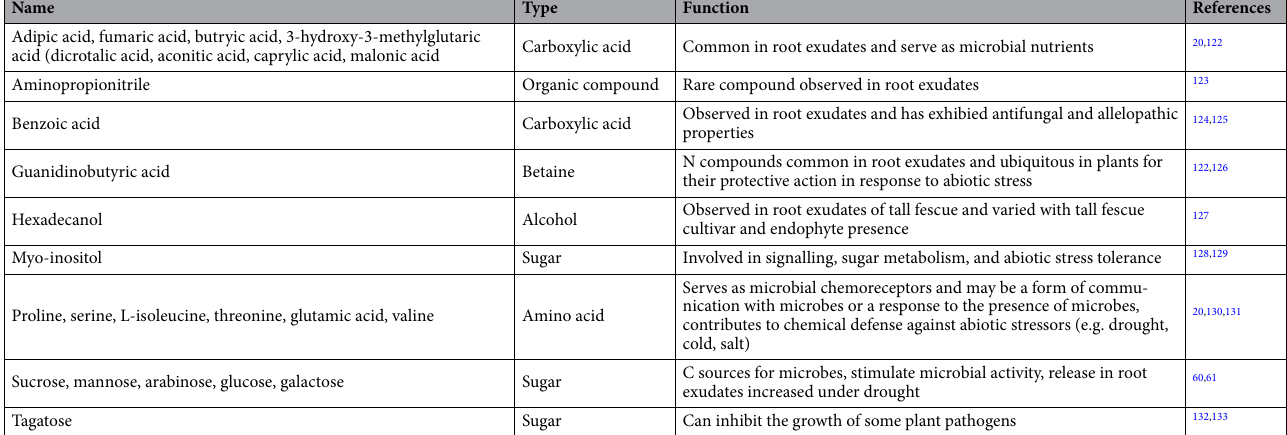
Fig. S8). Together, this suggests that root exudate composition can be modulated by drought stress severity 56,66 . For example, the intermediate severity of treatment B induced intermediate drought-related changes in root exudate composition compared to treatments A (control) and C (severe). Supporting our findings, root exudate composition has also been observed to differ between plants under drought, plants recovering from drought, and non-droughted plants 31 . However, to our knowledge, no study has investigated the effect of drought severity exudate compounds can promote drought resistance and/or support a rhizosphere microbiome that may pro- mote drought resistance. In support of our second hypothesis and described below, we found that the specific compounds and compound types that were driving the T2 treatment separation and/or were unique to the severe drought treatment, also have been observed to alter plant drought responses and the rhizosphere microbiome (Table 2). Identifying specific compounds linked to increasing drought severity with multiple analytical platforms (GC–MS, NMR, FTICR) helped us to elucidate mechanisms of root exudation that may be compound-specific 20 . Identification of compounds that affect plant drought responses. Plants produce compounds that promote drought resistance mechanisms including: providing hydrophobic protection against drying soil 30,67 , accumulating osmotically active solutes to maintain turgor (e.g., proline), providing antioxidant defense 68,69 , enhancing root growth, and stress hormone signaling 24,25 . Consistent with this, we observed an increase in drought-resistance-promoting compounds in root exudates with increasing drought severity (Table 2). For example, following drought treatment (T2), proline and D-gluconic acid were two of three identified GC–MS metabolites unique to treatment C (Fig. 5, Supplementary Figs. S4, S5), suggesting an increase in production of compounds associated with drought protection with increasing drought severity. These organic acids in root exudates can solubilize inorganic phosphates and enhance N availability, directly promoting plant growth 15,70–72 . Proline, an amino acid, is well-known as an osmolyte and osmoprotectant in plant drought response 30 , and can also contribute to cellular homeostasis, redox and antioxidant functions, and signalling 73–77 . Consistently, pro- line has been observed to increase in root exudates under drought 30 , and Bokhari et al. 47 observed that proline composed the majority of amino acids in the root exudates of greenhouse-grown blue grama. Our observed drought severity-induced association with proline, a N-rich compound, is consistent with the drought-severity- induced association with CHOS, CHON, and CHONS compounds, driving the separation between drought severity treatments (Fig. 4). CHONS compounds also may be linked to the release of mucilage (proteins, extra- cellular DNA) used for defense against pathogens, lubricating the root zone, and stabilizing soil particles 20,78 . An increase in N-rich compounds in root exudates with increasing drought severity may indicate a surplus N being released by roots 38 or reallocation of N belowground. N compounds in root exudates may be related to the observed decline in photosynthesis with drought severity because N is the most prevalent element in RUBISCO, the enzyme responsible for photosynthesis (Chapin 134 ). In addition to CHONS, CHOS compounds influenced treatment separation at T2, suggesting that the release of sulfur-containing compounds in root exudates also may be related to plant response to drought severity. Sulfur-containing compounds are often secondary metabo- lites that contribute to plant defense and stress response, yet not much is known about them 79 . Identification of compounds that affect the rhizosphere microbiome. Root exudate compounds most strongly associated with treatment separation at T2 as detected with GC–MS (Fig. 3, Supplementary Figs. S4, S5) and NMR (Supplementary Figs. S6, S7) have been commonly observed in root exudates to alter the rhizosphere microbiome (Table 2) 17,18,27,80 . In contrast to compounds that attract microbes, some root exudate